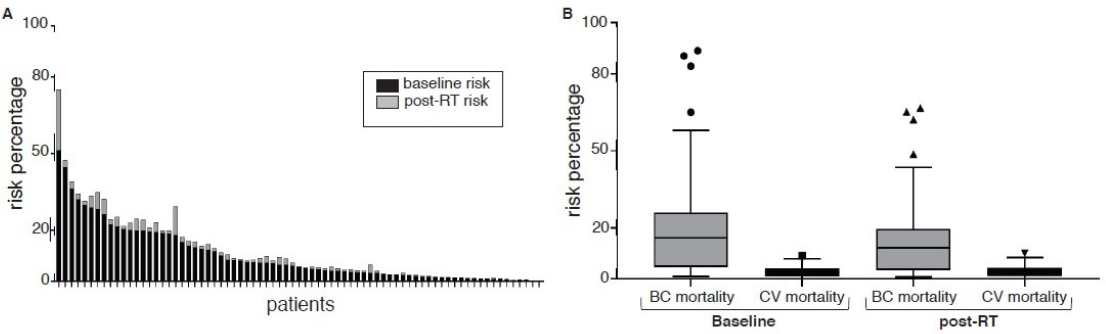
Figure 1. ( A ) Baseline and post-RT 10-year major cardiovascular event risk. ( B ) Baseline and post-RT 10-year breast cancer and cardiovascular risk mortality. Circles show baselines values, triangles are post-RT. Table 2. Treatment volume, fractionation, and corresponding cardiac